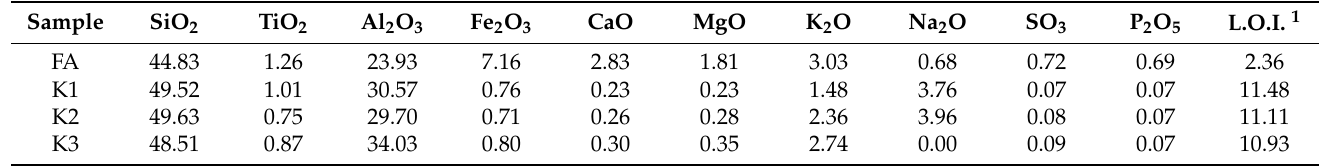
Table 1. XRF of metal oxides (mass%) of the fly ash (FA) and kaolin samples (K). Sample SiO 2